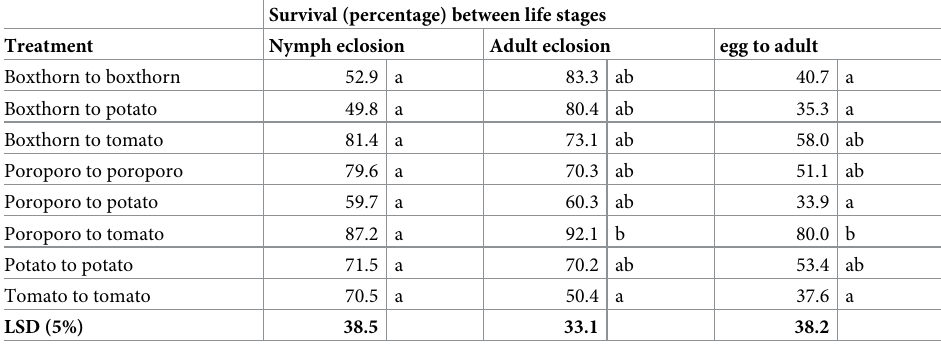
Table 3. Survival (percentage) between life stages of tomato potato psyllid progeny from adults originating from the same or different host plant species. Within a column, means (n = 6) with a letter in common within a column did not differ significantly on the basis of an unrestricted 5%-level LSD